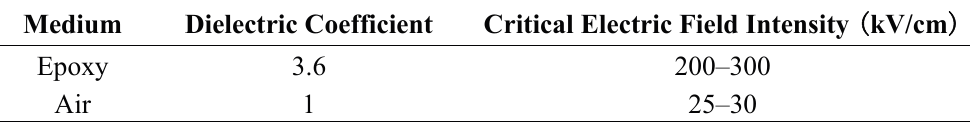
Figure 16. Distribution diagram of the electric field intensity in different media. Table 2. Medium